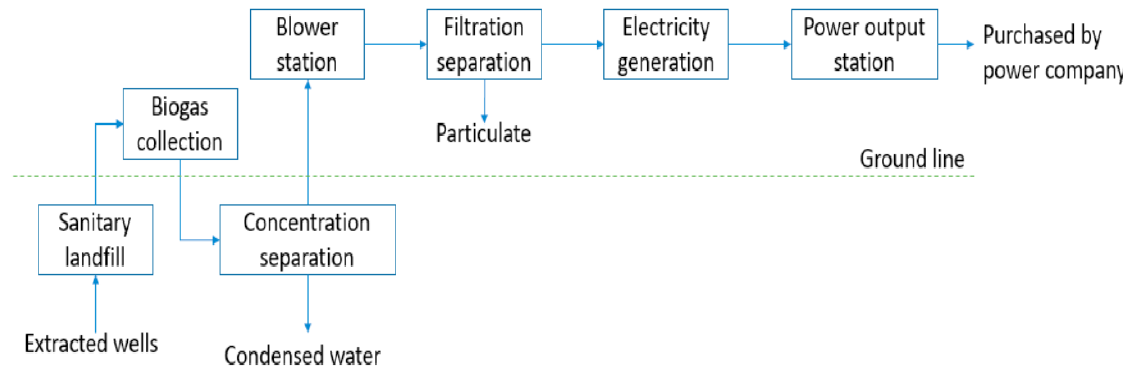
Figure 4: Flow diagram of electricity generation from landfill biogas